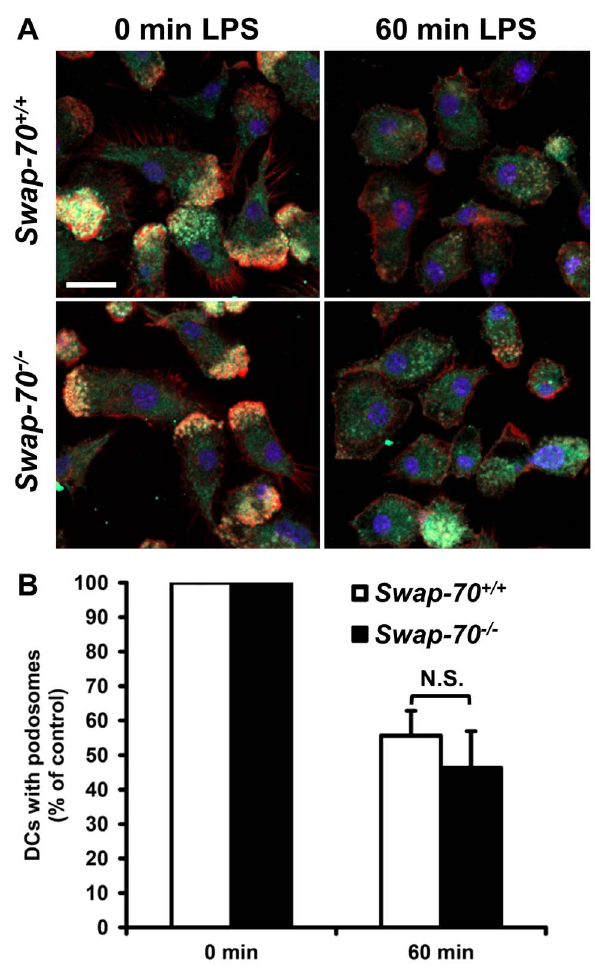
Figure 2. LPS-induced podosome disassembly is not affected by SWAP-70 deficiency in DCs. ( A ) Swap-70 + / + and Swap-70 –/– DCs were treated with or without LPS for 60 min. Cells were stained with anti-Vinculin FITC (green), rhodamine phalloidin for F-actin (red), and DAPI for the nucleus (blue) and analyzed by confocal laser scanning microscopy. ( B ) Quantification of the number of DCs exhibiting podosome clusters with and without LPS treatment for 60 min. Graph indicates the number of cells with podosomes after LPS treatment relative to control (without LPS treatment). Mean values of 3 independent experiments with error bars indicating + SD are shown. N.S. denotes not significant.